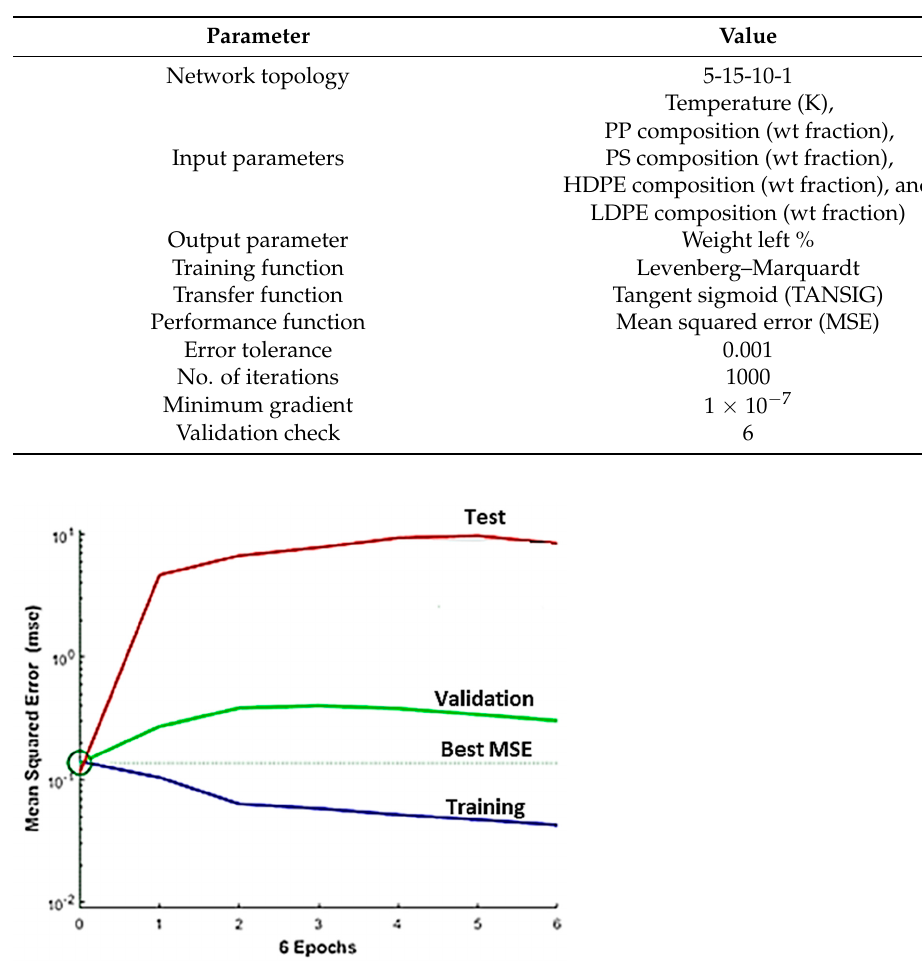
Table 5. Parameters of the developed ANN model.